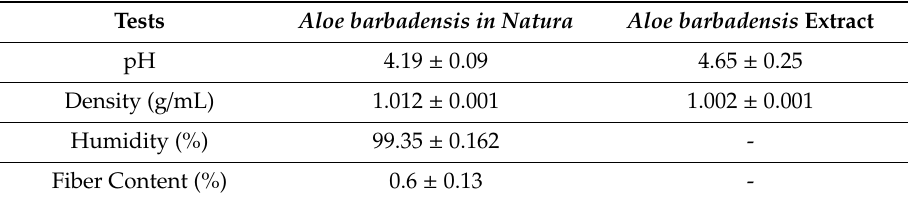
Table 1. Data from the pH, density, and humidity assays of Aloe barbadensis in natura and extract.